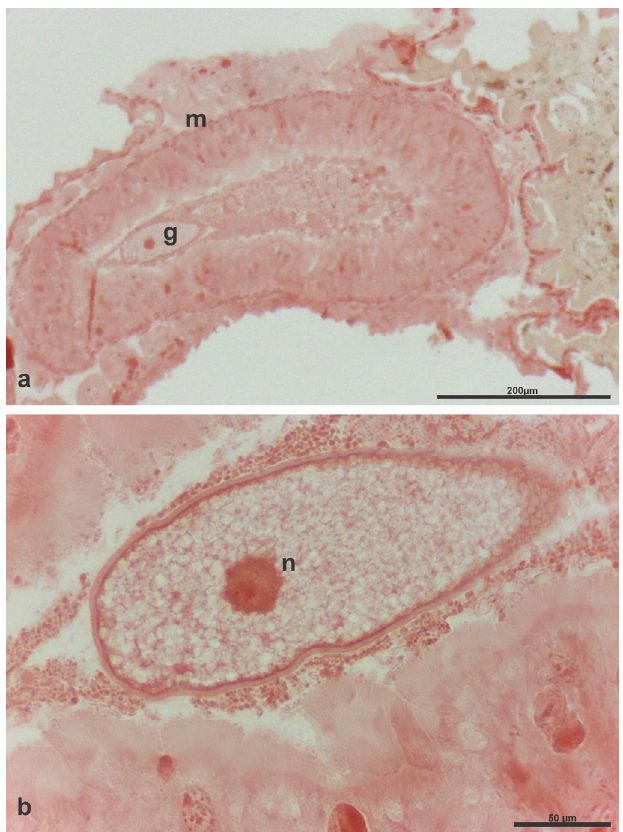
Fig 3 . Histological sections of the worker midgut (m) of Ruptitermes reconditus stained with xylidine Ponceau. a , b Free gamont (g) in the gut lumen. n =